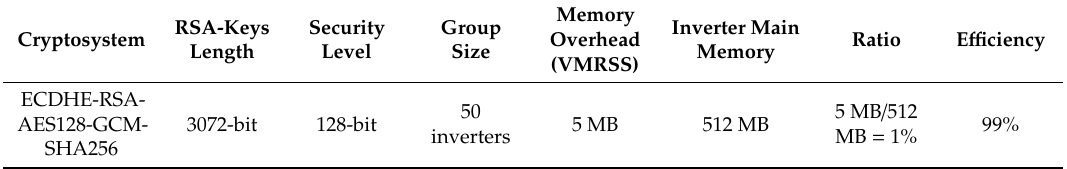
Table 5. Memory overhead: main results.